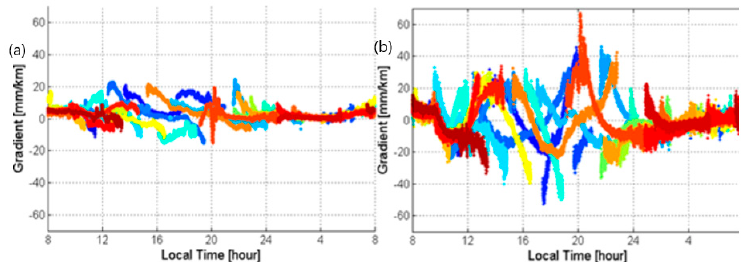
Figure 6. The east–west gradient ( a ) and the north–south gradient ( b ) for the ionospheric delay on 4 March 2001.